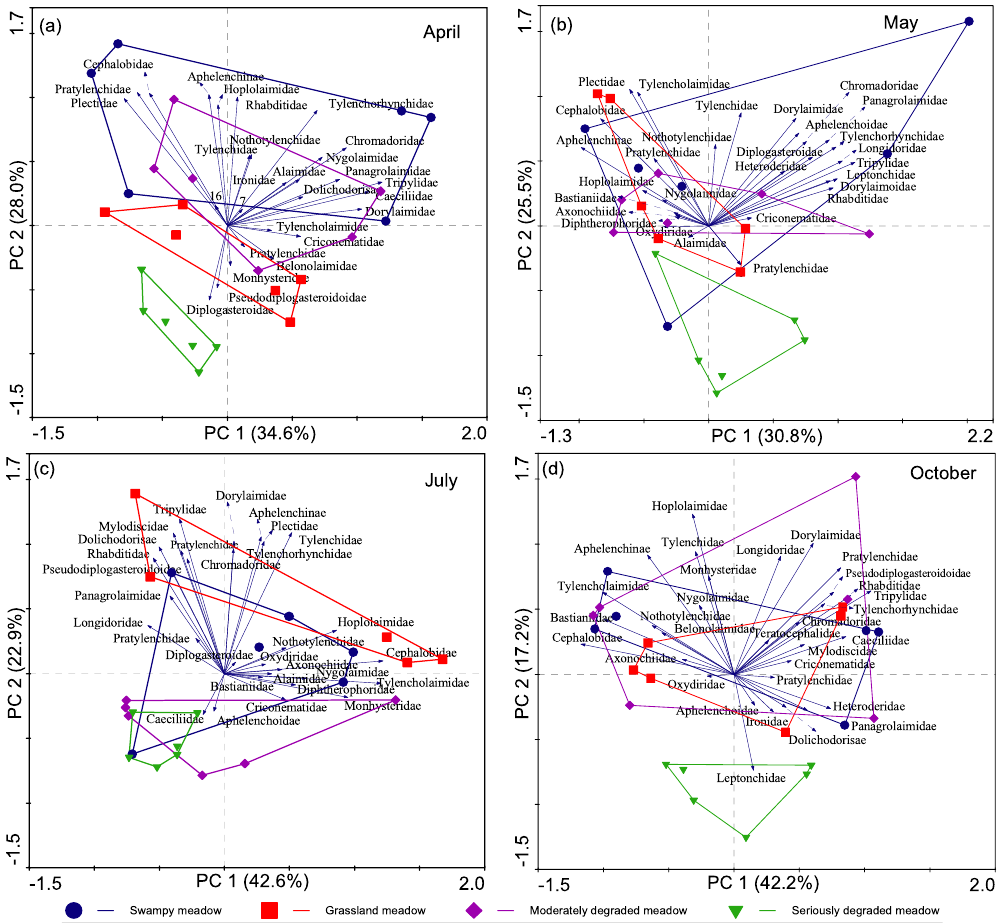
Figure 2. Variations in community structure of the soil nematodes in different Zoigê Wetland habitats in four months. Short arrows that indicate rare taxonomic groups were omitted for